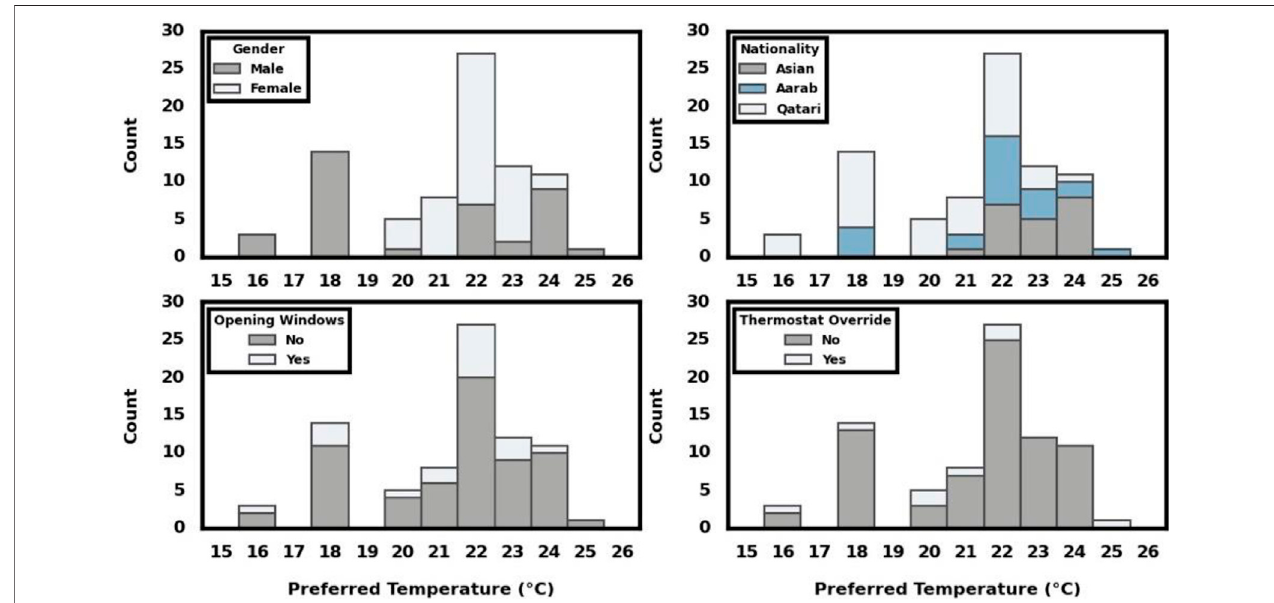
FIGURE 12 | Distribution of user indoor temperature preference based on demographic and human building interactions.